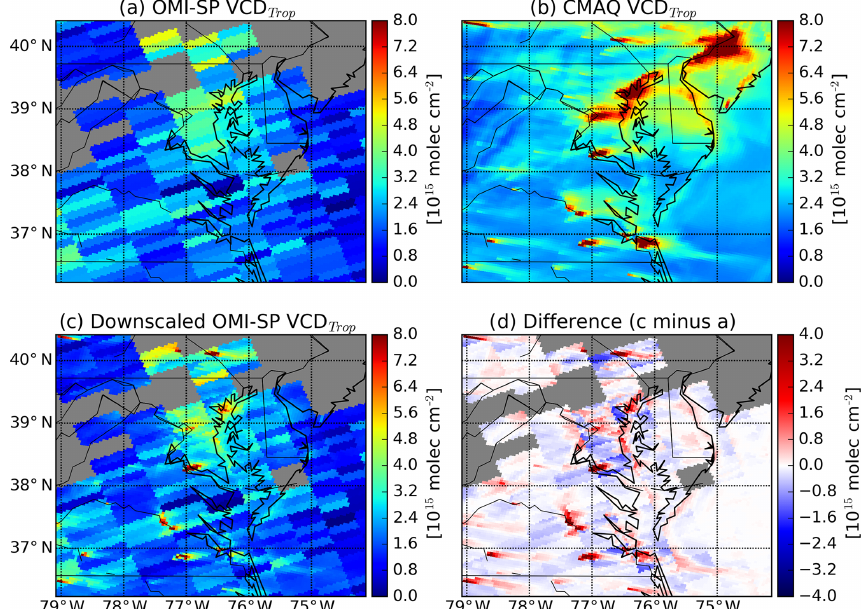
Figure 5. Tropospheric NO 2 VCD maps from (a) OMI SP, (b) CMAQ, and (c) downscaled OMI over Maryland on 29 July 2011. Panel (d) shows the difference between downscaled and standard tropospheric NO 2 VCD data (c minus a). The gray areas represent pixels with an effective cloud fraction > 0 . 3. Table 3. Comparison between NCAR, TD-LIF, and Pandora NO 2 observations. Campaign NCAR vs. TD-LIF NCAR vs. Pandora TD-LIF vs. Pandora No. of profs. Mean diff. (%) Mean diff. (%) Mean diff. (%) (Pandora) (TD-LIF – NCAR) r (Pandora –